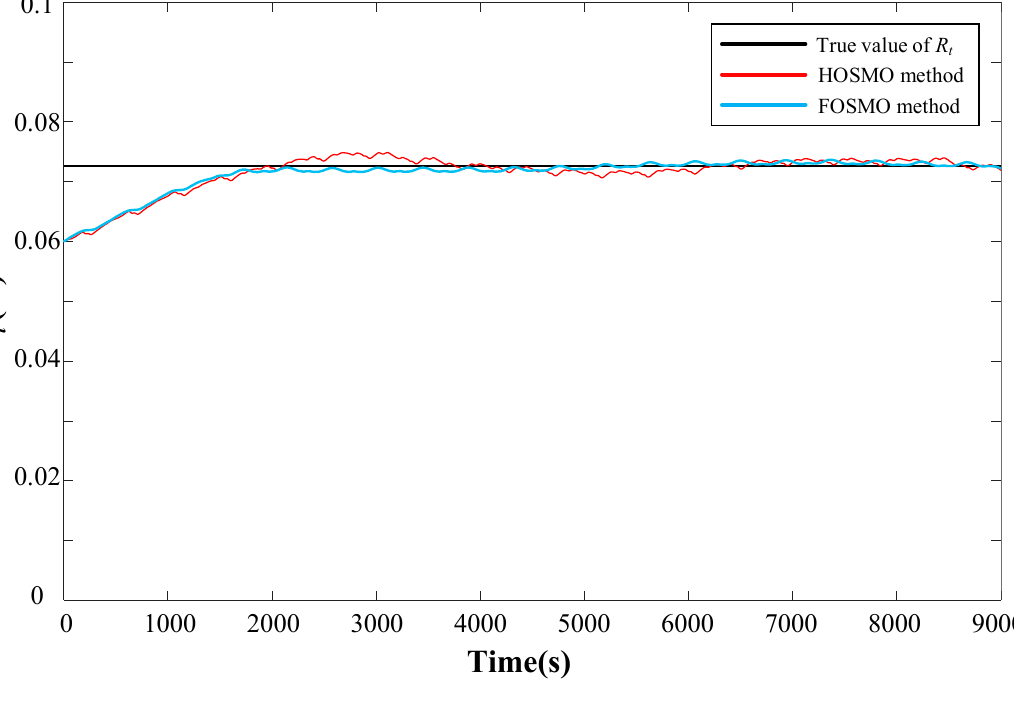
Figure 9. Comparison of R t estimated by FOSMO and HOSMO with the true value of R t .